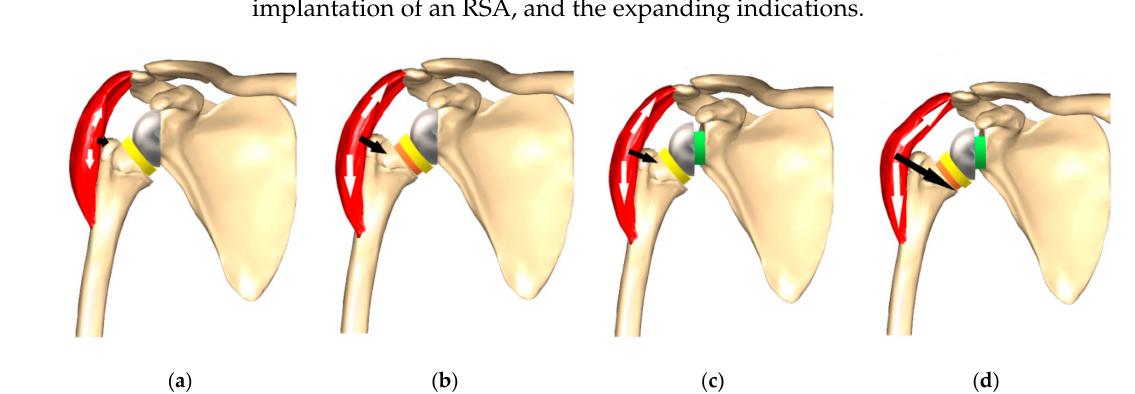
Figure 1. Deltoid wrapping. ( a ) Poor deltoid wrapping due to medialization. ( b ) Improved deltoid wrapping due to humeral lateralization ( c ) Improved deltoid wrapping due to glenoid lateralization. ( d ) Further increase in deltoid wrapping due to combined bipolar